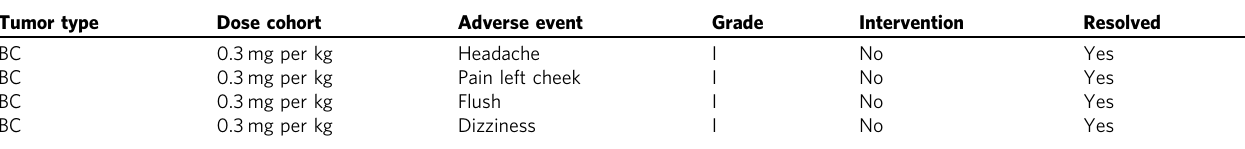
Table 2 Adverse events.